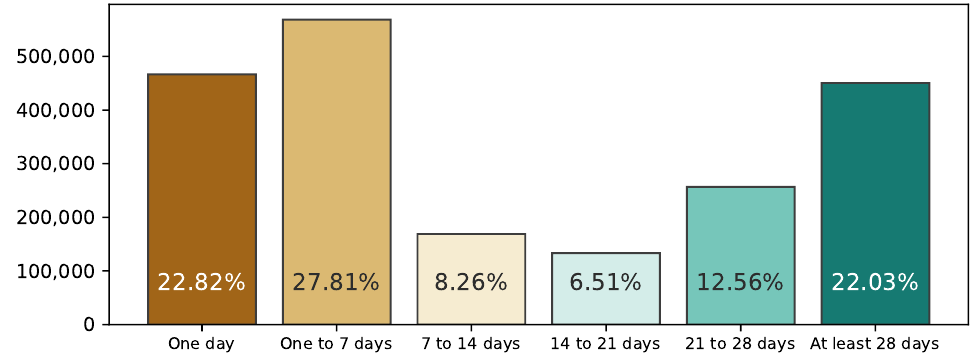
Figure 2. SIM card distribution by the number of active